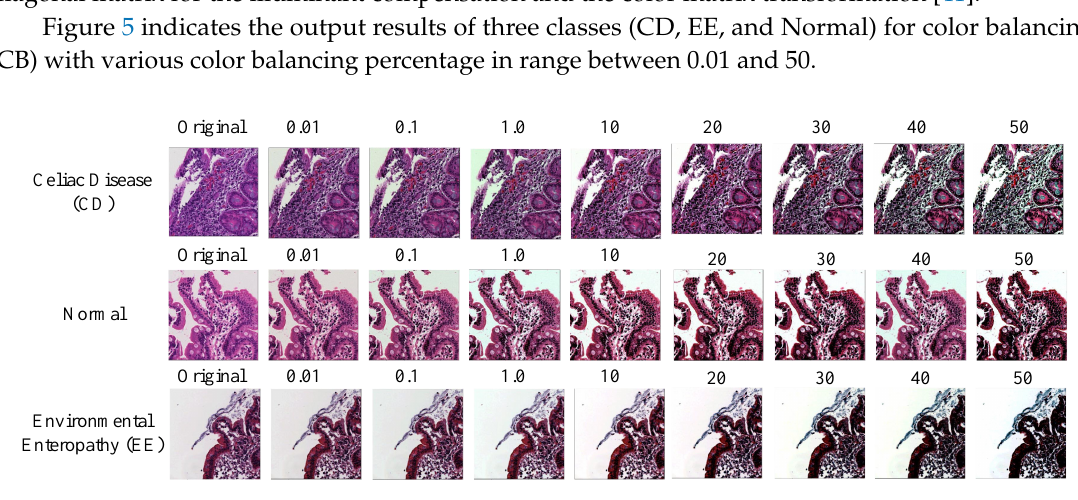
Figure 5. Color Balancing samples for the three classes.